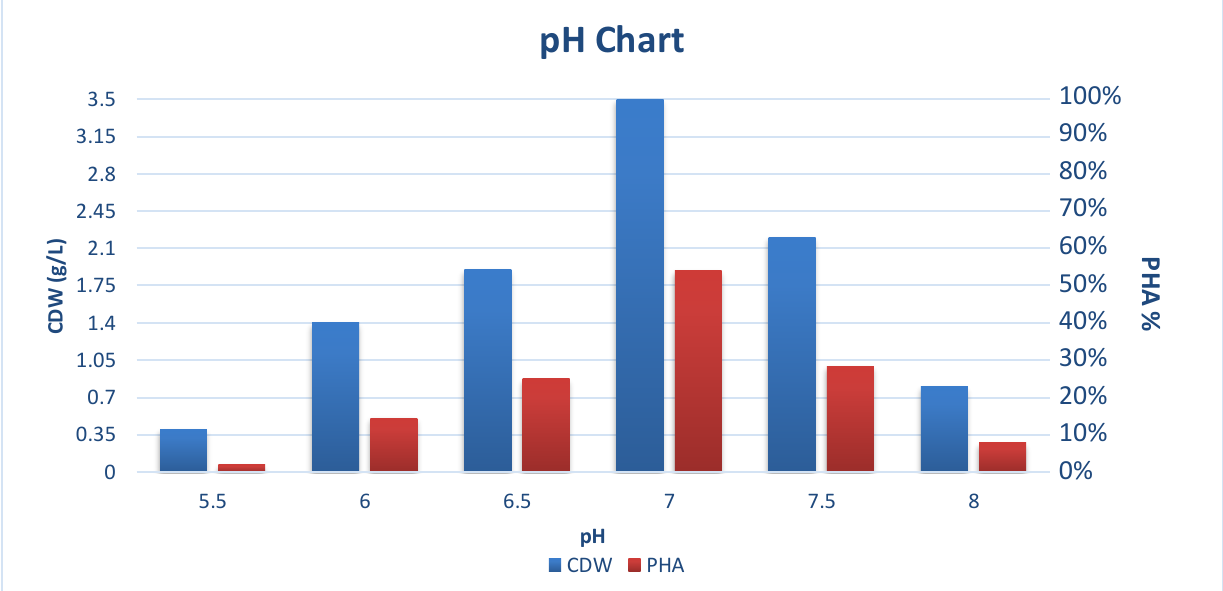
Figure 5: Effects of different pH values on growth rate and PHA production with A. lwoffii